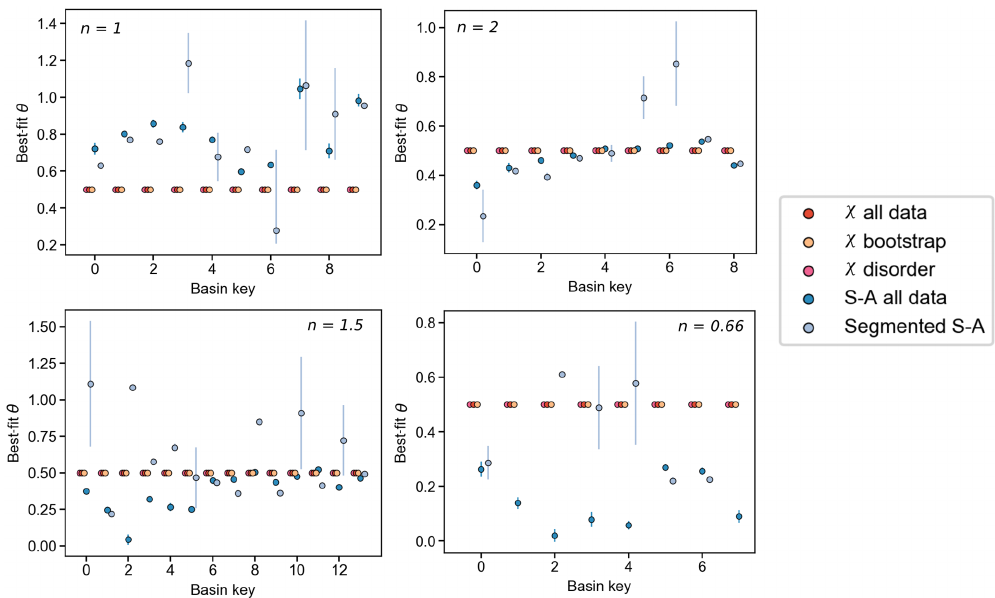
Figure 6. Plots showing the predicted best-fit θ for each basin and each method for m/n = 0 . 5, where n = 1, n = 2, n = 1.5, and n = 0.66. The χ methods are shown in shades of red and the slope–area methods are shown in shades of